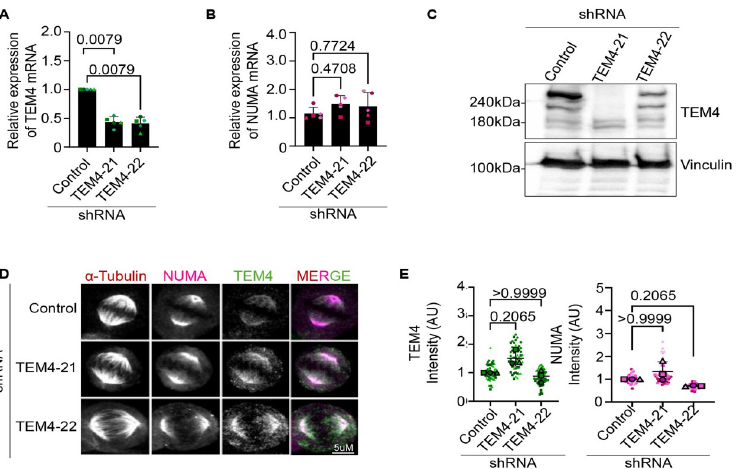
Fig 5. TEM4 depletion decreases TEM4 mRNA and protein levels but no effect on spindle staining by the TEM4 antibody. A: TEM4 gene expression levels on HeLa-T-REx cells transduced with lentiviruses for 72h expressing shRNA targeting TEM4. Levels of TEM4 mRNA were measured by RT-qPCR in 5 independent biological replicates. Gene expression of targeted mRNA was normalized to two reference genes, GAPDH and HPRT-1. B: Cells treated as in A, and NuMA mRNA levels were measured in Hela-T-REx cells depleted for TEM4. The graph shows the relative expression of NuMA mRNA from 5 independent biological replicates, normalized to two reference genes. C: HeLa- T-REx cells stably expressing two independent inducible shRNAs targeting TEM4 were generated. ShRNA expression was induced for 48 hours using 0.5 μ g/ml doxycycline before total cell extraction with RIPA buffer followed and Western blotting was performed with the indicated antibodies. D: Immunofluorescent images of HeLa-T-REx cells expressing shRNA to knockdown TEM4 after 72 hours of induction. Cells were synchronized in mitosis after 10 hours of release from double thymidine block and fixed for 10 minutes with PTEMF buffer. Fixed cells were stained with anti-TEM4 (green), anti- α -tubulin for the spindle microtubules (red) anti-NuMA (pink). Scale bar = 5 μ m. E: Cells were treated as in D and quantification of TEM4 and NuMA intensity on the mitotic spindle is shown in replicates from 3 independent experiments. A minimum of 20 cells was counted and the graphs show super plots of 3 biological replicates. One-way non-parametric Anova test was performed to compare the mean values between the tested